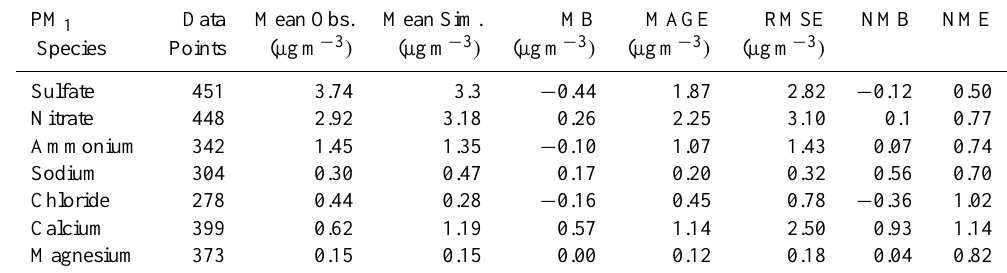
Table 4. Comparison of PMCAMx predictions with hourly observations taken at T1 site during 10–31 March 2006. PM